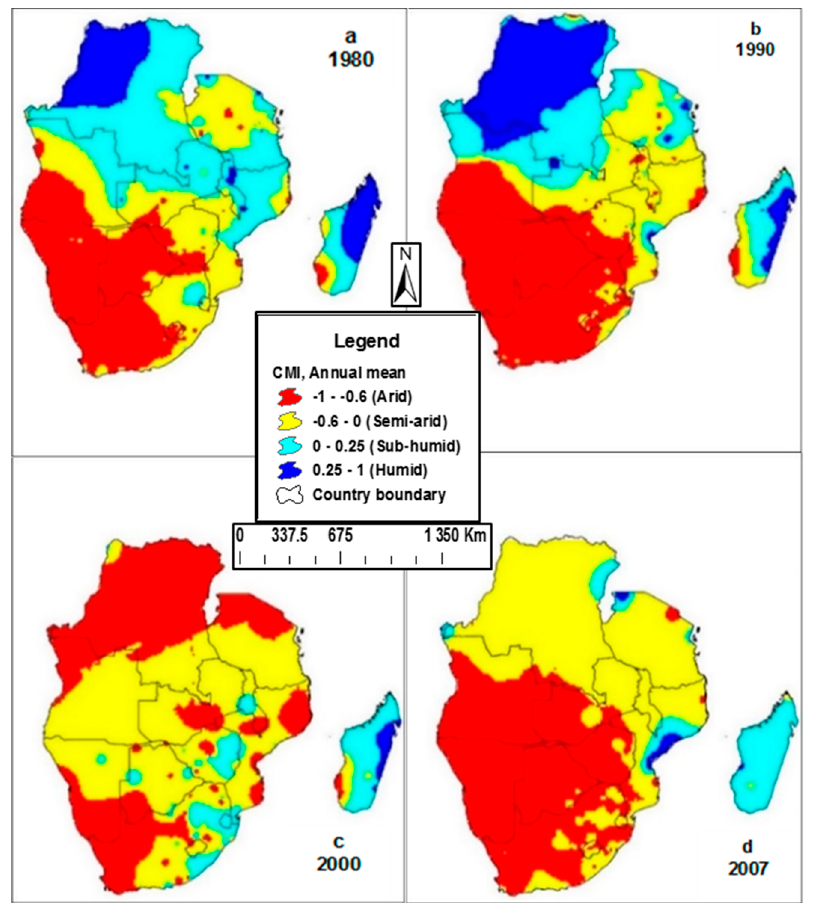
Figure 4. Spatio-temporal changes in water scarcity and aridity in the SADC region. Source: Developed by authors.